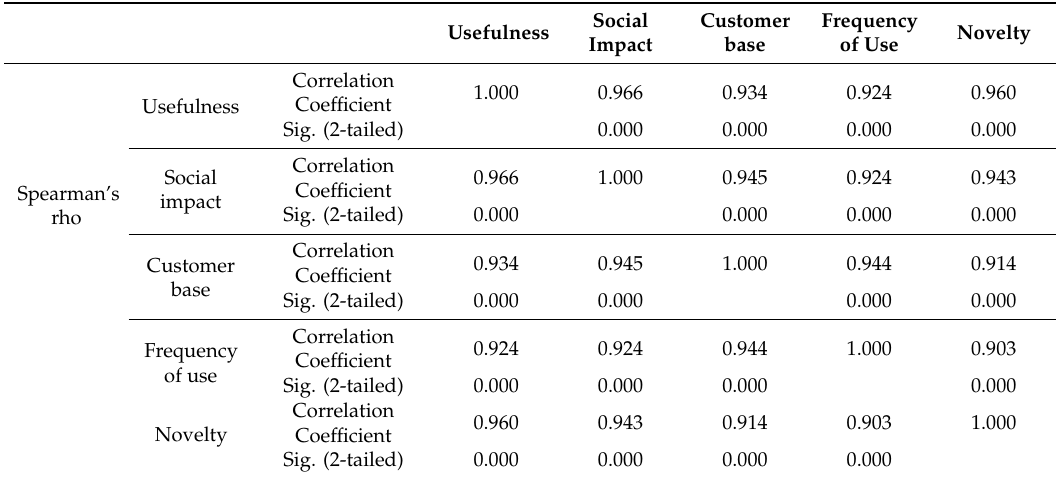
Table 1. The results of correlation analysis of the five criteria.